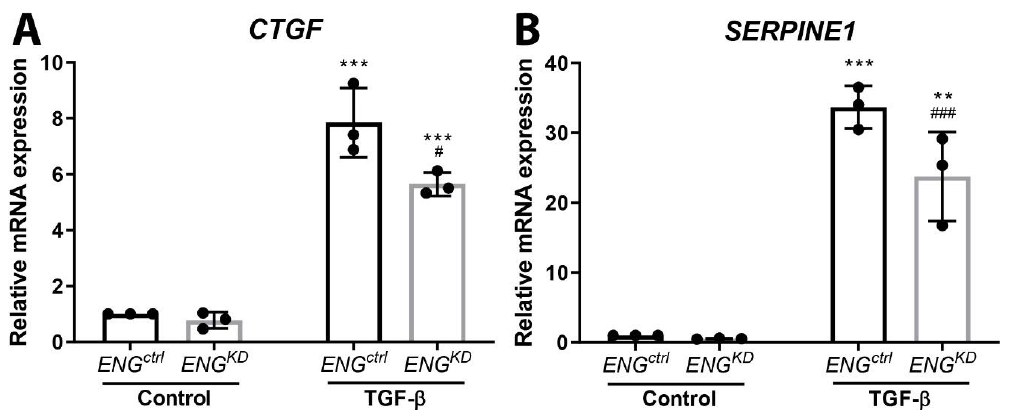
Figure 6. ENG KD fibroblasts have reduced TGF-β-induced upregulation of pro-fibrotic TGF-β downstream target genes. ENG ctrl and ENG KD fibroblasts were incubated with 5 ng/mL TGF-β1 for 24 h, after which CTGF ( A ) and SERPINE1 ( B ) mRNA levels were measured using qPCR. The housekeeping gene HPRT was amplified as a control, and each mRNA level is plotted relative to the respective unstimulated (control) ENG ctrl group. mRNA levels are plotted relative to unstimulated (control) ENG crtl fibroblasts, and summary data are presented as the mean ± SD from three experiments. ** p < 0.01 and *** p < 0.001 versus unstimulated fibroblasts from the same cell line (Student’s t-test); # p < 0.05 and ### p < 0.001 ENG ctrl versus stimulated ENG KD fibroblasts (Student’s t- test).